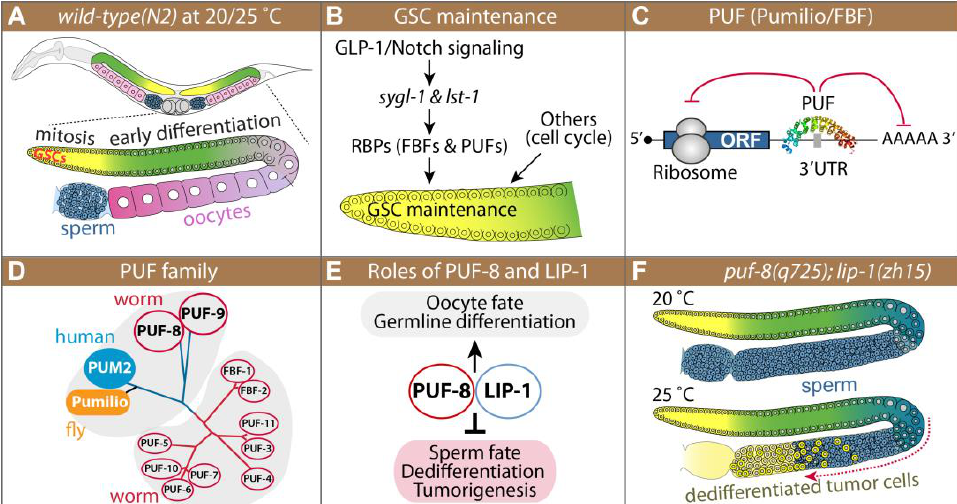
Figure 1 . Introduction. ( A ) Schematics of adult C. elegans and its germline. Germ cells at the distal end of the germline, including GSCs, divide mitotically (yellow). As germ cells move proximally, they enter meiosis (green) and differentiate into either sperm (blue) or oocytes (pink). ( B ) GLP-1/Notch signaling and intrinsic regulators control GSC maintenance. ( C ) PUF as a translational repressor. ( D ) The PUF protein family is widespread throughout eukaryotes. The phylogenetic tree is adapted from Wickens’ 2002 review [7]. ( E ) PUF-8 and LIP-1 control many cellular processes. ( F ) Schematics of puf-8(q725); lip-1(zh15) germline phenotypes at 20 °C and 25 °C. Yellow circles in proximal gonads indicate dedifferentiated tumor cells.